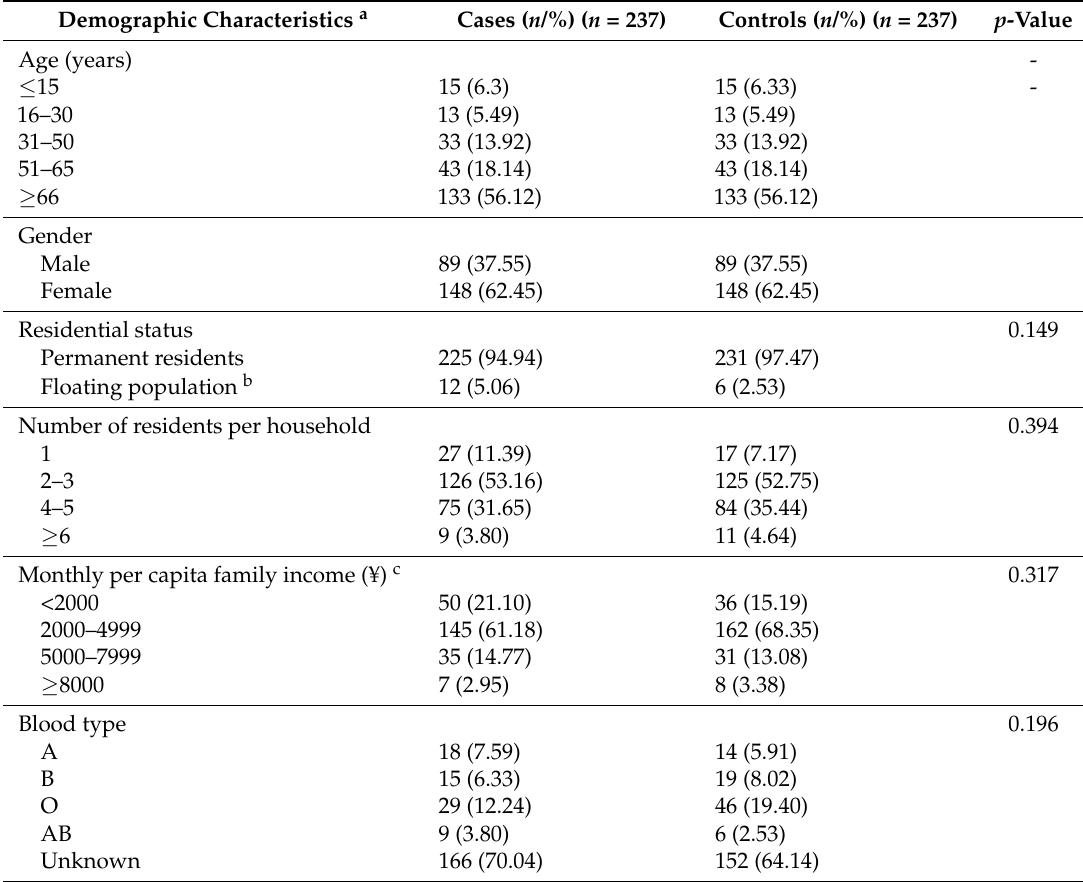
Table 1. Demographic characteristics of cases and